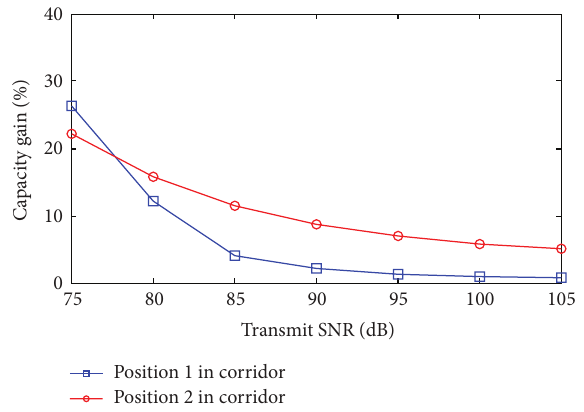
Figure 10: TAS capacity gains with different transmitting SNRs in